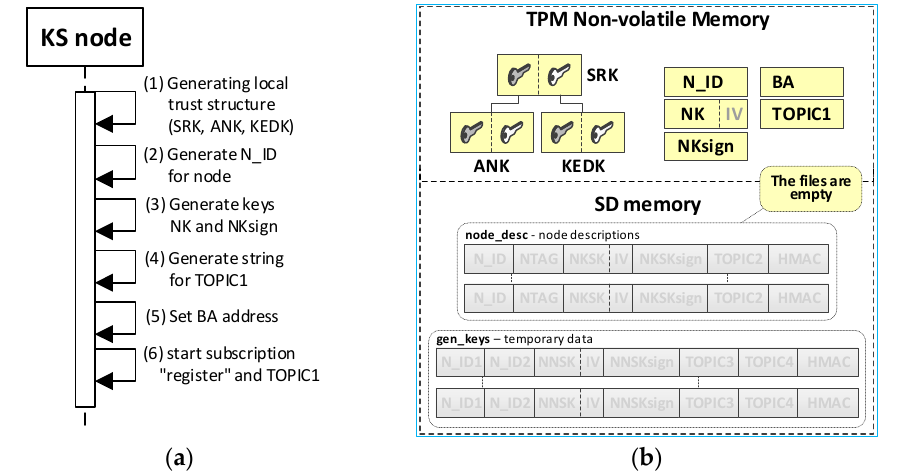
Figure 7. The sequence diagram for the KS node initialization procedure ( a ) and the data stored on the KS node after the initialization procedure ( b ).